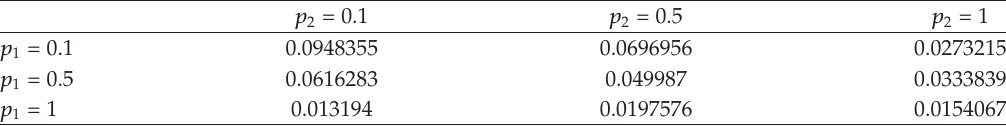
Table 3: MSV of filtering errors x 1 (cid:5) k (cid:6) − (cid:11) x 1 (cid:5) k/k (cid:6) , k (cid:7) 1 , 2 ,...,